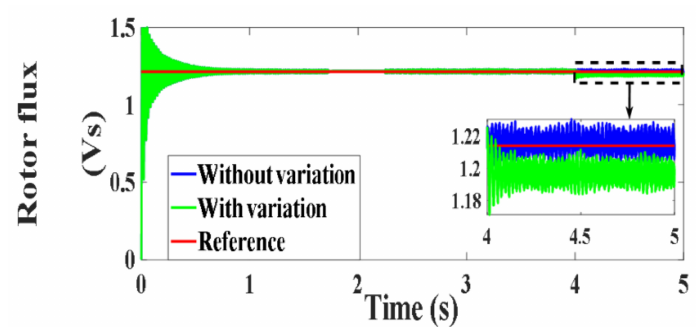
Figure 130. Rotor flux under PVC (Vs).